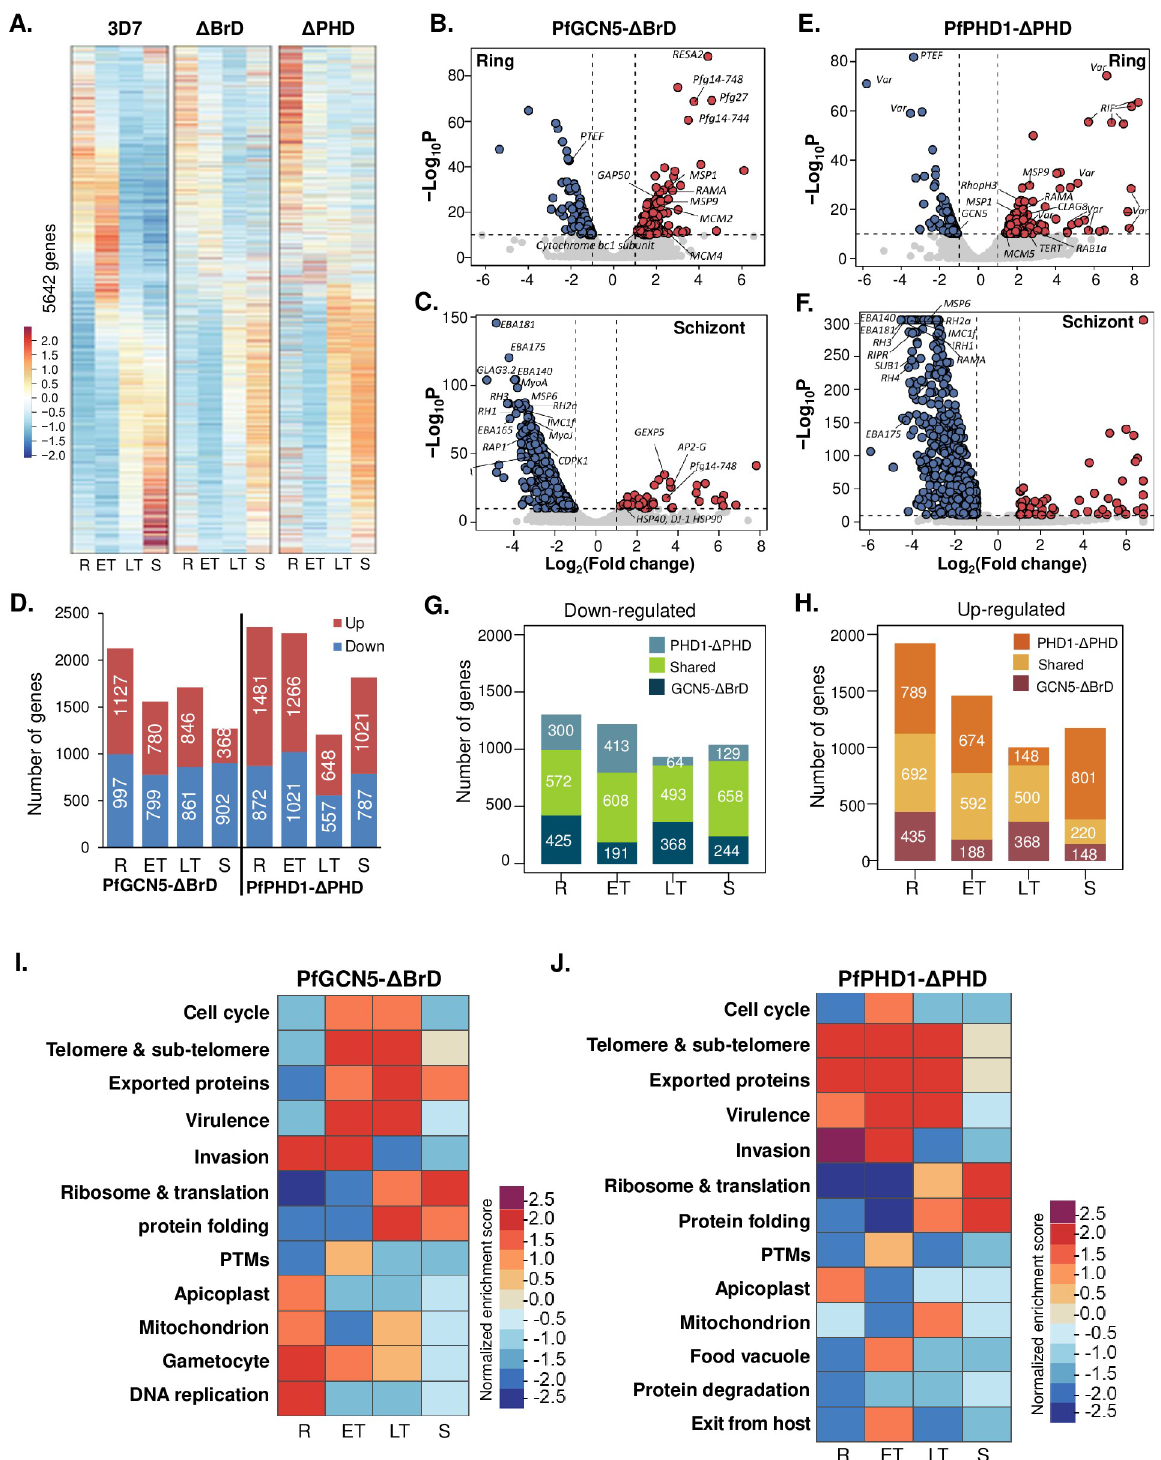
Fig 4. Global transcriptomic changes up domain deletions in PfGCN5 and PfPHD1. (A) The phaseograms of transcriptome from the WT 3D7, PfGCN5- Δ BrD::GFP ( Δ Brd), PfPHD1- Δ PHD::GFP ( Δ PHD) showing the disturbance of the cascade-like gene expression pattern in the deletion mutants at different developmental stages. R, ring; ET, early trophozoite; LT, late trophozoite; S, schizont. (B, C) Volcano plots showing altered gene expression at the ring (B) and schizont (C) stages in PfGCN5- Δ BrD::GFP compared to the WT 3D7. The x-axis indicates log 2 (Fold change) of the transcript level in PfGCN5- Δ BrD::GFP compared to WT 3D7, while the y-axis indicates -log 10 of the P values.(D) Number of